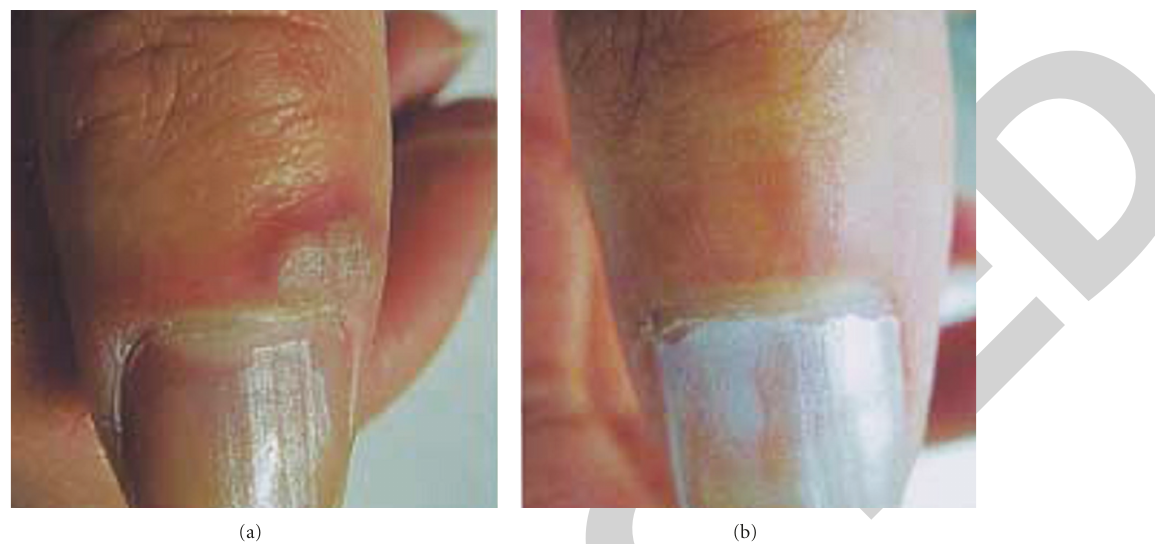
Figure 1: Refractory wart on right index finger (a). It was treated using local application of calcitriol 0.5 μ g solution and disappeared completely three months later